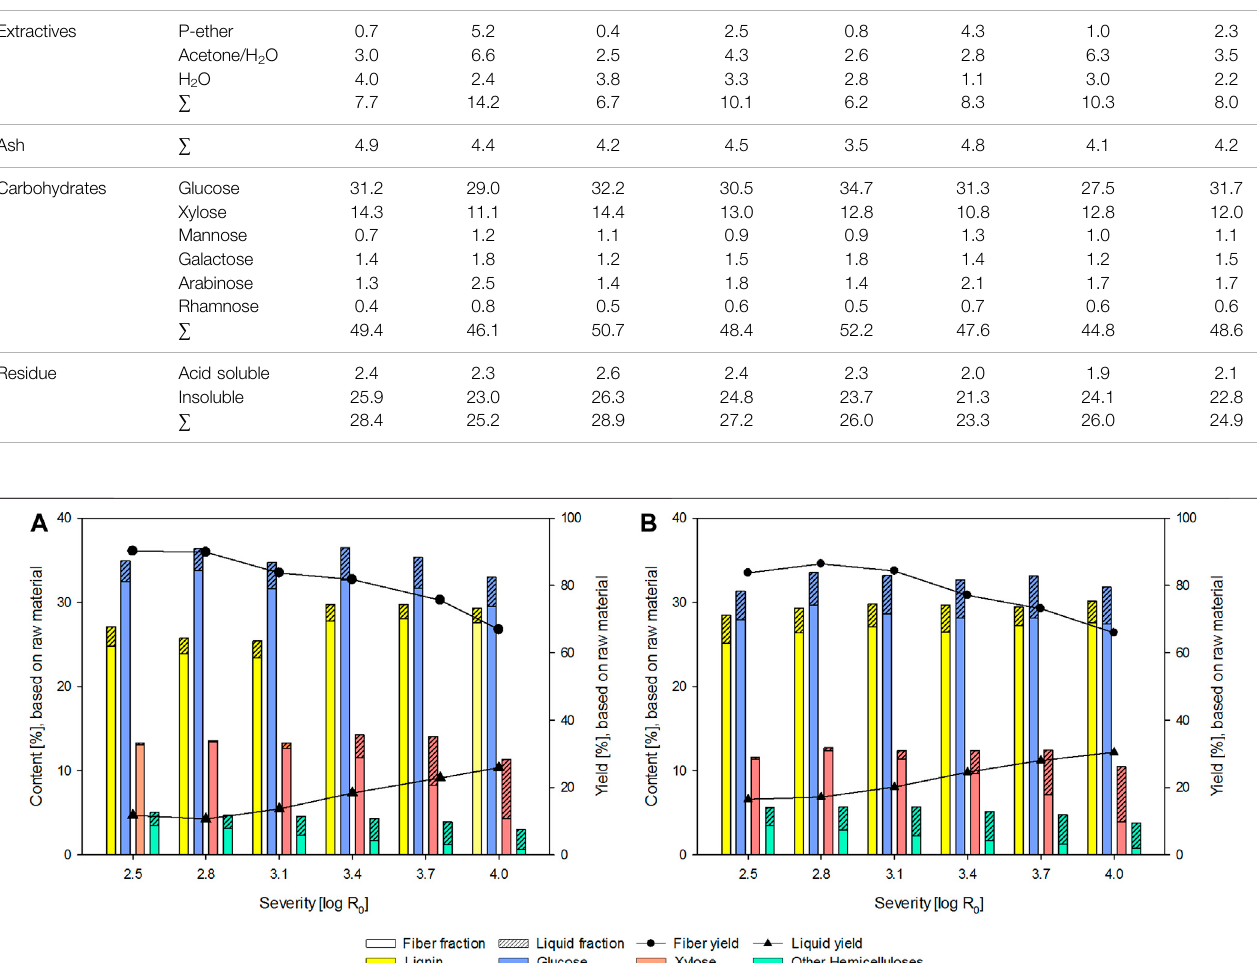
Frontiers in Chemistry |